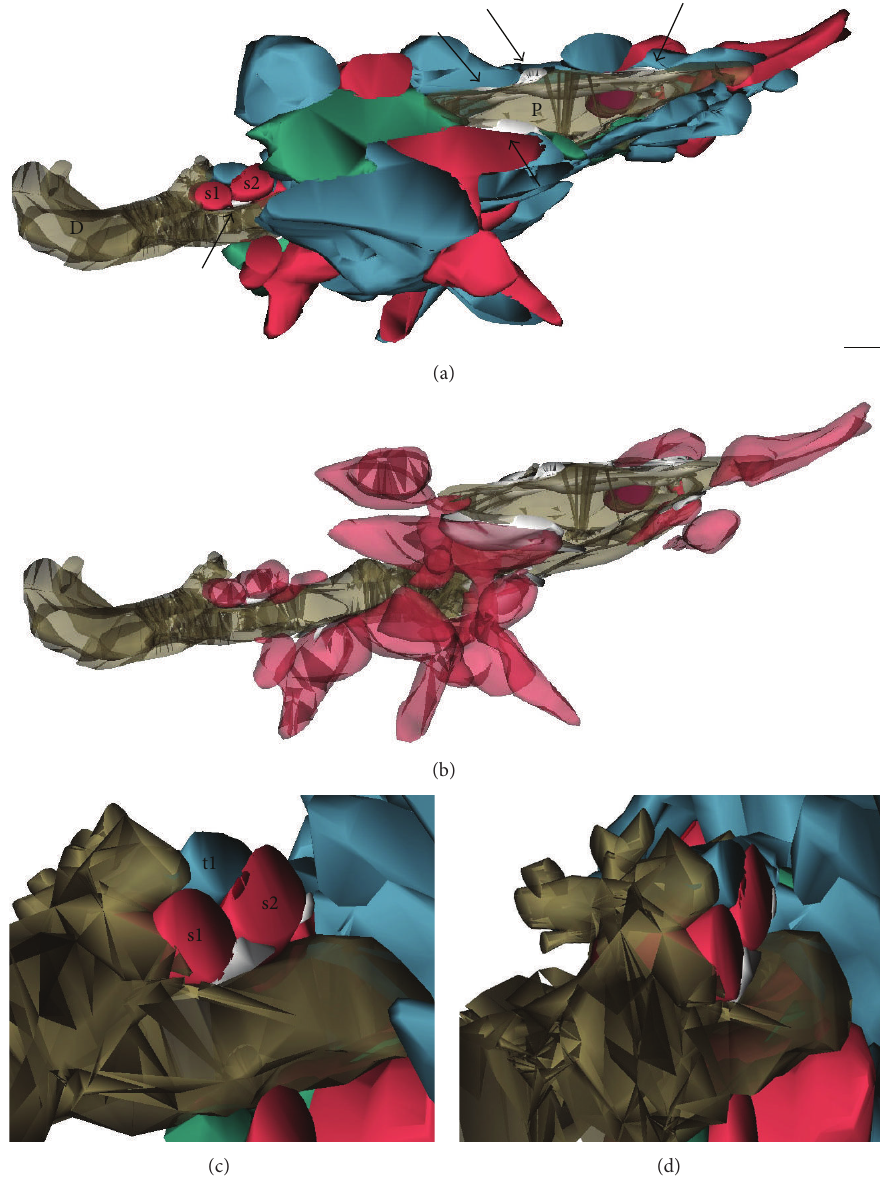
Figure 2: Three-dimensional reconstruction of microglial relationships with multiple synaptic elements at multiple synapses in physiological conditions. (a) Partial reconstruction of a microglial proximal process (P), cut in transverse, and a distal protrusion (D), cut longitudinally, in adolescent mouse visual cortex. The purple element indicates a phagocytic inclusion. The process and protrusion simultaneously contact multiple axonal terminals (in blue), dendritic spines (in red), and perisynaptic astrocytic processes (in green) and are distinctively surrounded by extracellular space pockets (arrows) of various sizes and shapes (in white). (b) Additional view showing only microglia, dendritic spines, and extracellular space. (c) and (d) Insets illustrating the three-dimensional relationships between the distal protrusion, one axonal terminal (t1), two dendritic spines (s1 and s2; postsynaptic density in dark red), and a pocket of extracellular space (in white), which are partially reconstructed. For clarity, an astrocytic process was removed from the scene. Scale bar: 250 nm. Reproduced from Tremblay et al.